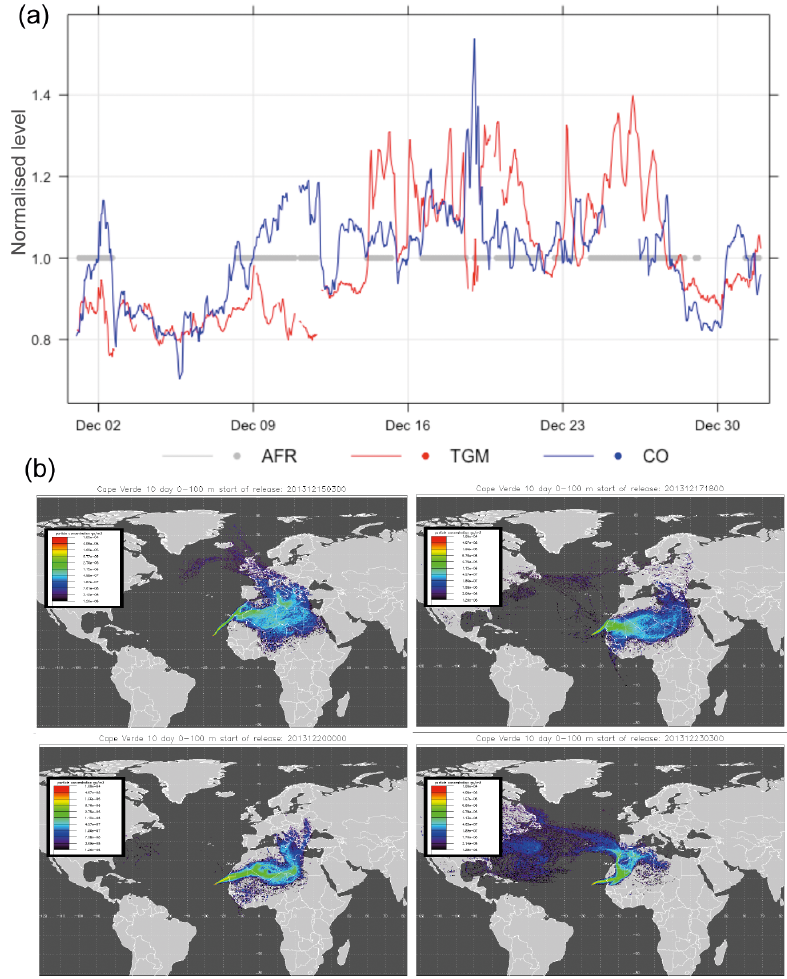
Figure 8. (a) Time series of TGM and carbon monoxide. The plot is normalised by dividing by the compounds’ mean value, and the grey dots indicate when the air was characterised as AFR. The shaded periods correspond to the 10-day back trajectories in (b) . Clockwise from top left: 15 December 2013, 03:00GMT; 17 December 2013, 18:00; 23 December 2013, 03:00; and 20 December 2013,